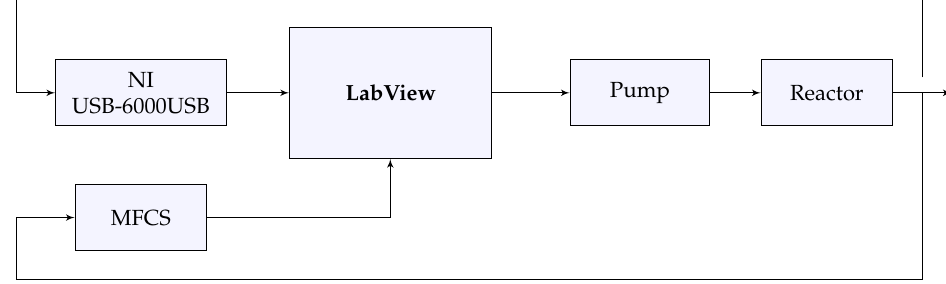
Figure 13. Real-time implementation